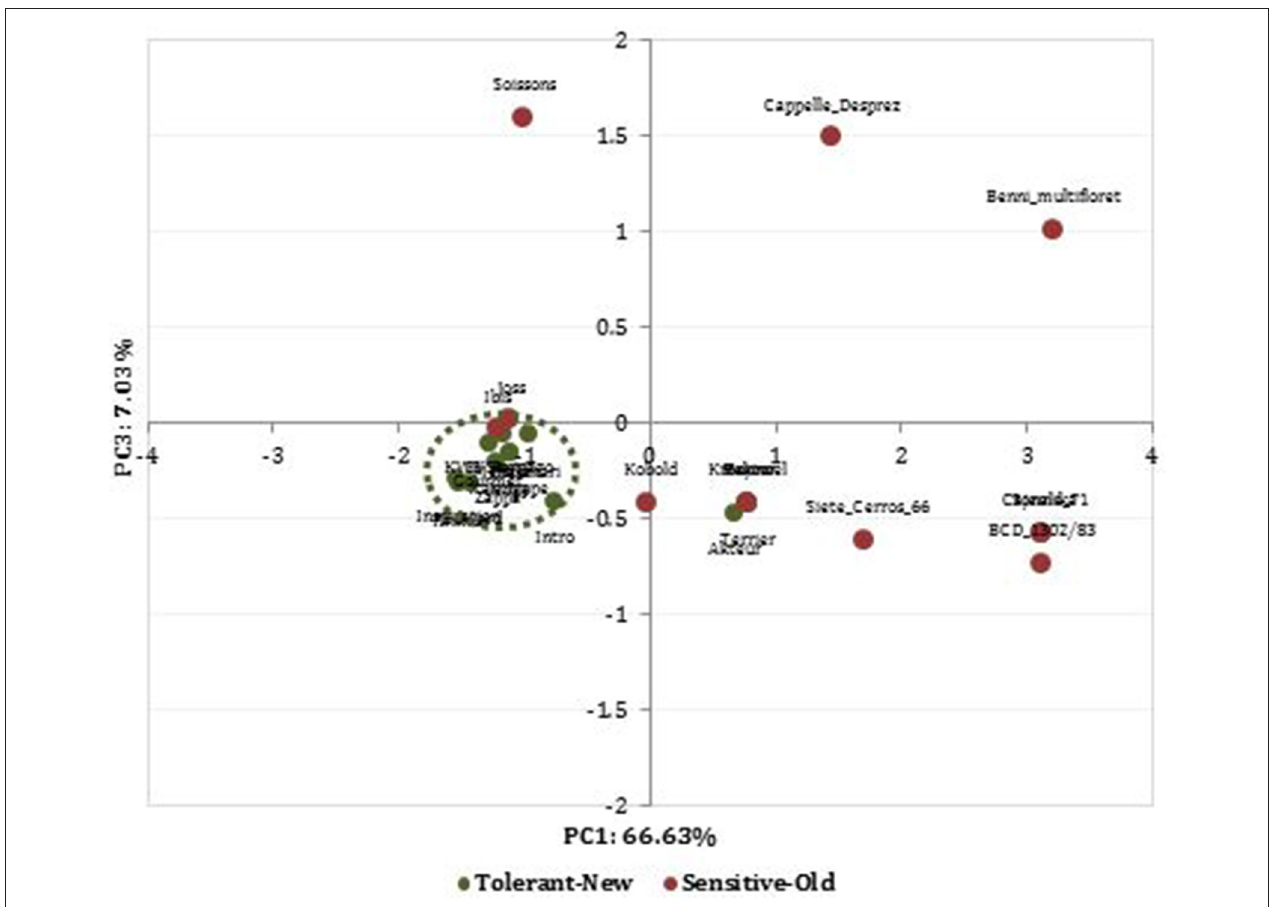
FIGURE 5 | Principal component analysis (PCA) plot using a PCA matrix (Tassel 5.2) estimated with data from 30 SNPs involved in breeding progress of drought-tolerant (green color) and drought-sensitive (red color) wheat cultivars previously identified among the studied population.